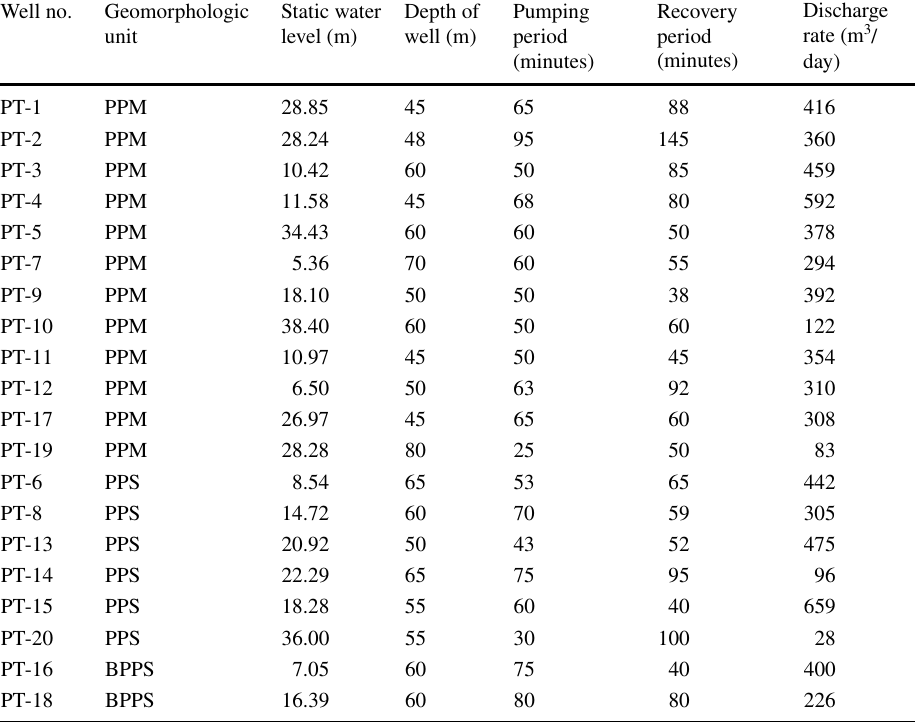
Table 1 Summary of the pumping test